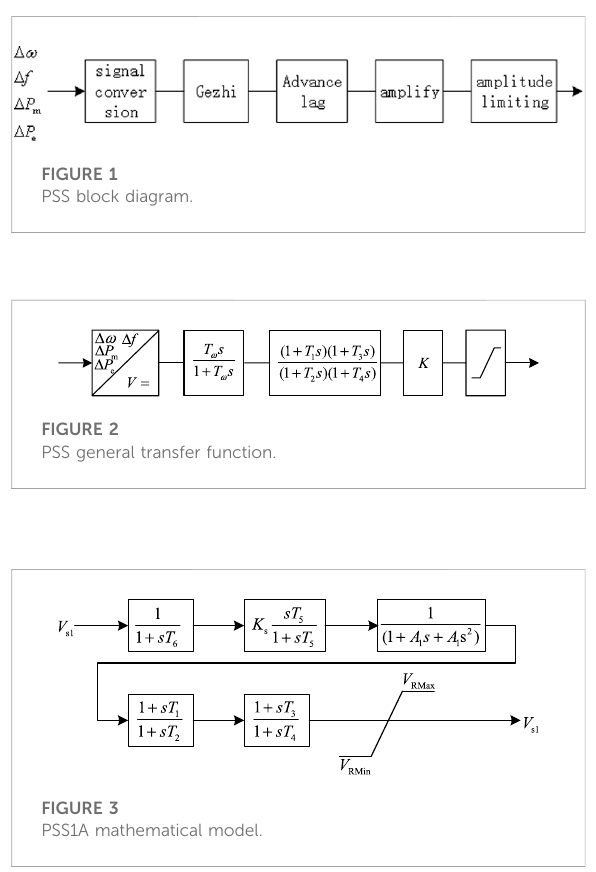
FIGURE 3 PSS1A mathematical